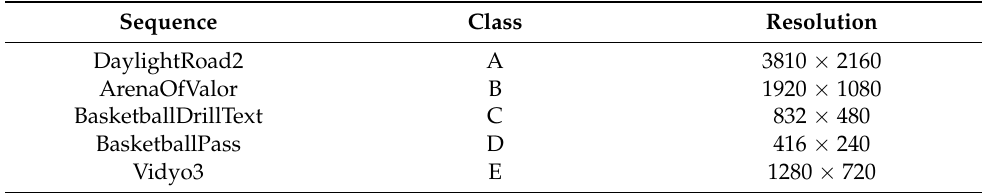
Table 2. Table of video sequence